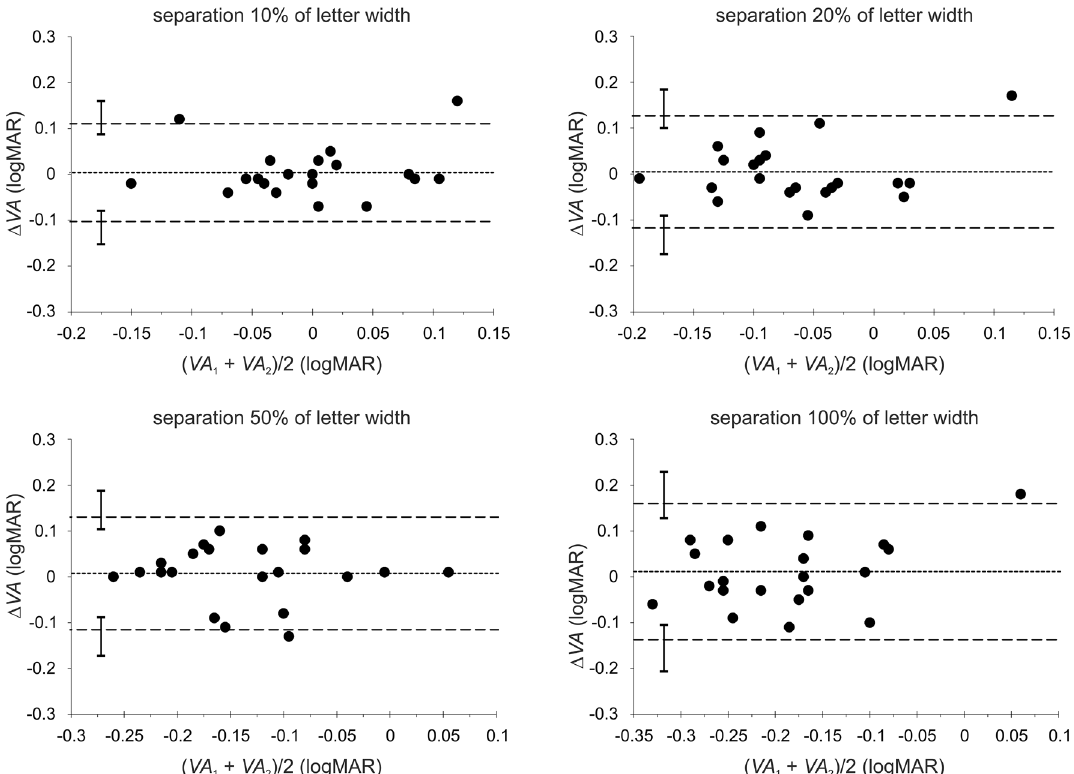
Figure 2. Bland and Altman 43 plots depicting the difference ∆ VA in logMAR between the first VA 1 (test) and second VA 2 (retest) measurements against their average for the high (− 90%) contrast level. The dashed lines represent the 95% limits of agreement (LoA) and the dotted lines the mean differences. The error bars shown in each panel represent the 95% confidence intervals for the Bland–Altman LoAs 44